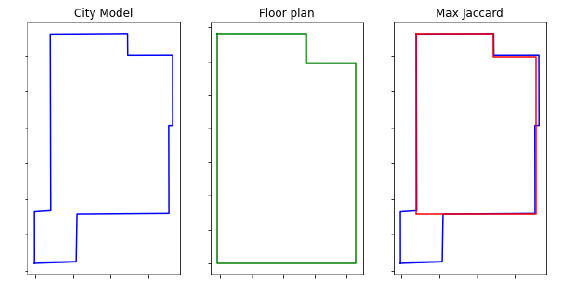
Figure 4. Maximum Jaccard / IoU